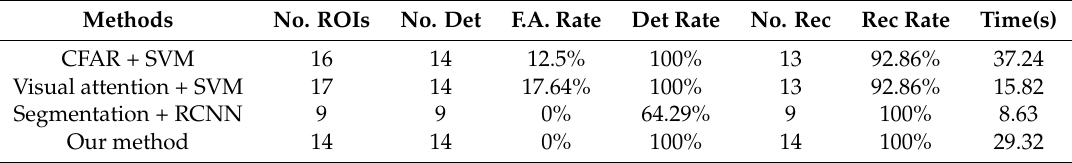
Table 4. Results on a large scene synthetic aperture radar (SAR) image with simple